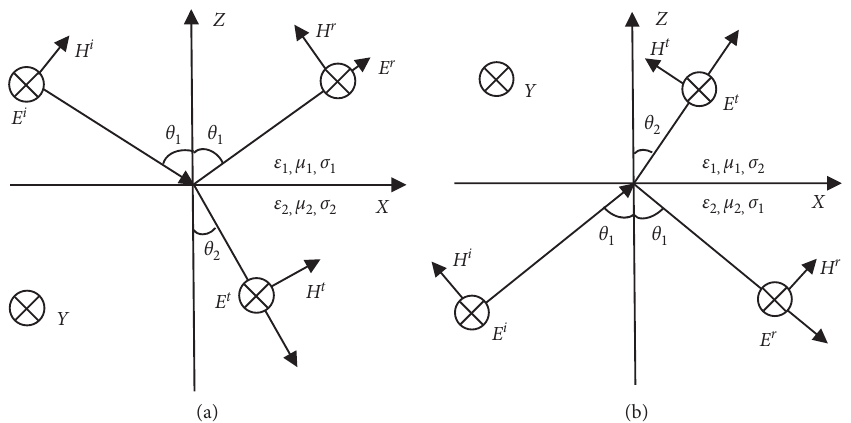
Figure 3: Schematic diagram of reflection and refraction at the interface of two media of H pol. (a) Propagation from medium 1 to medium 2. (b) Propagation from medium 2 to medium